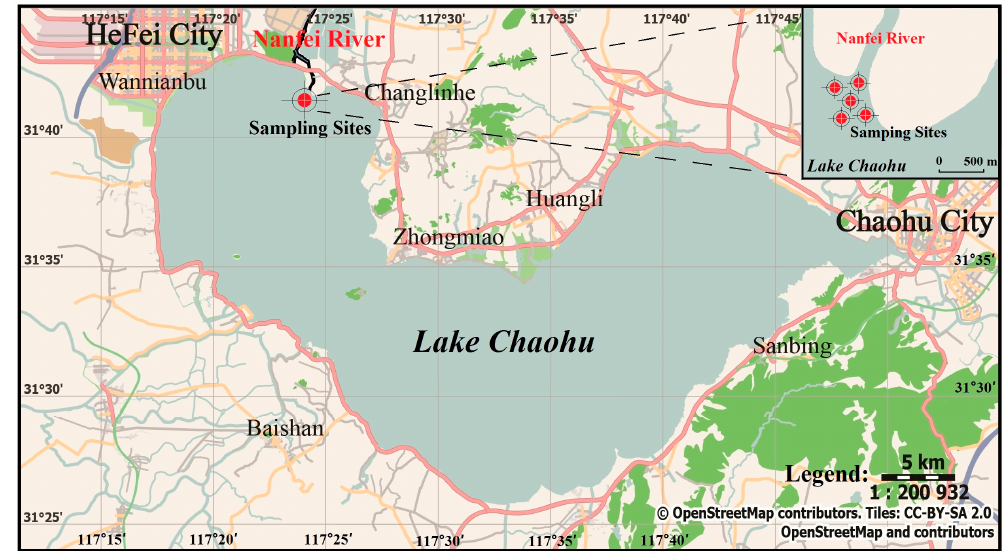
Figure 1. Map of Lake Chaohu in China and the sampling sites (31°41 ′ 51 ″ N, 117°24 ′ 16 ″ E).